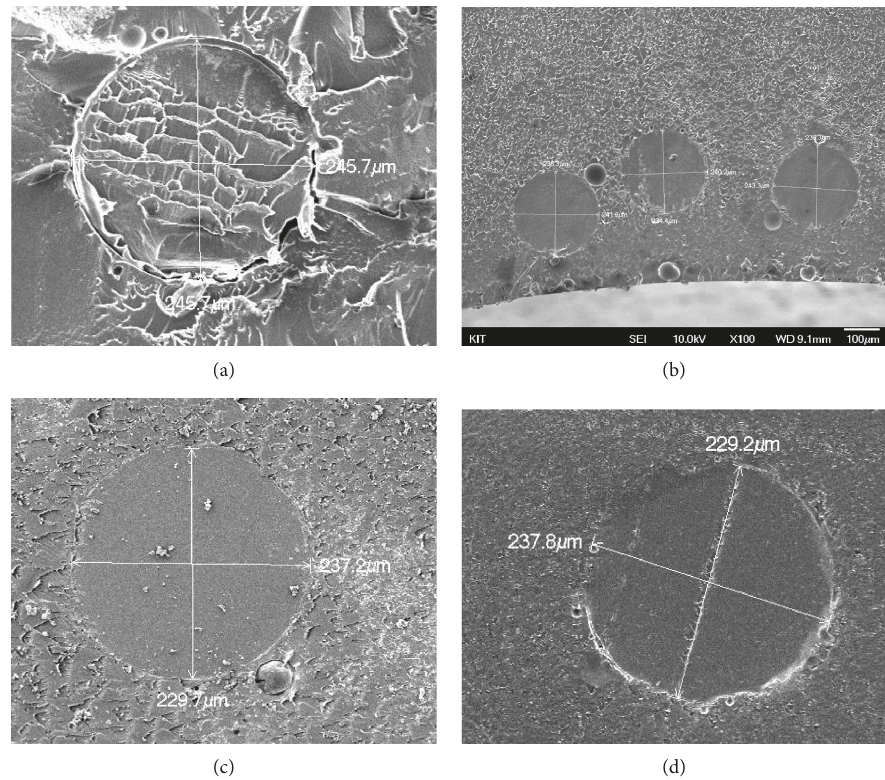
Figure 16: Mechanical clad removal using sandpaper with different abrasion numbers. (a) 1 time. (b) 2 times. (c) 4 times. (d) 6 times.